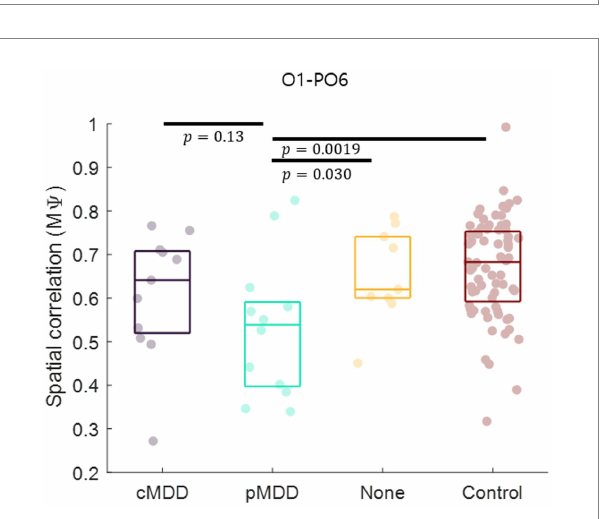
FIGURE 8 Biomarker as the disruption of inter-regional long-range spatial correlation between left occipital and right occipital region of patients with past major depressive disorder. The mean of spatial correlations ( M ψ in Eq. 2) between channels of left occipital and right occipital regions. Each dot represents each participant. The three horizontal lines in the box indicate 25, 50, and 75% of the data, respectively. The result of statistical test that the spatial correlation in the pMDD group was lower than that in other groups was displayed as a p -value (rank-sum